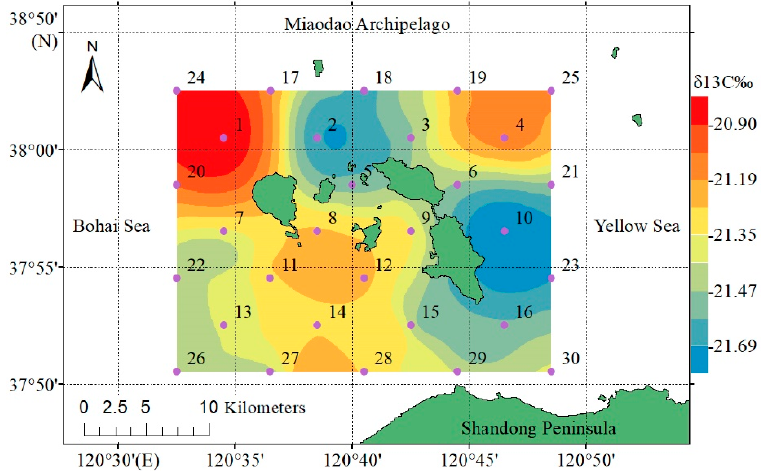
Figure 8. SOM distribution of the sea area adjacent to the Miaodao Archipelago.